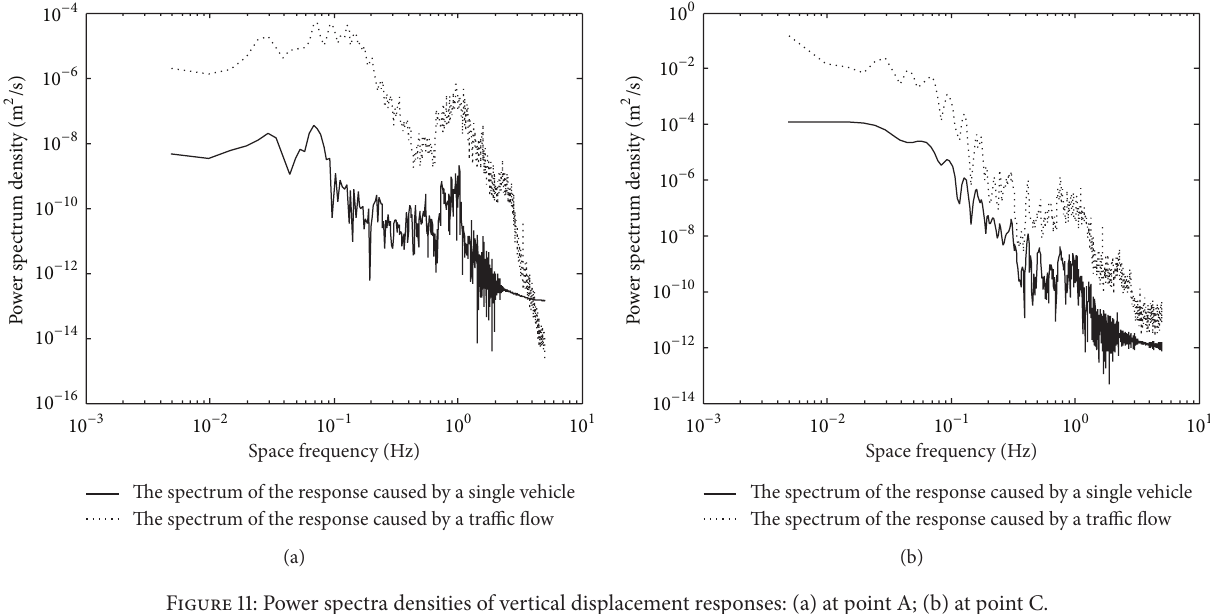
Figure 11: Power spectra densities of vertical displacement responses: (a) at point A; (b) at point